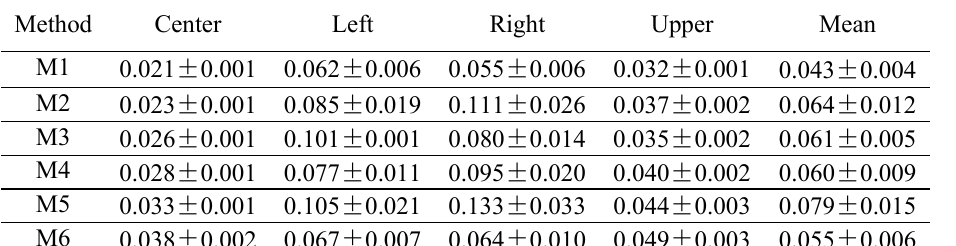
The summary statistics of mean and standard deviation of relative error for iris center localization.